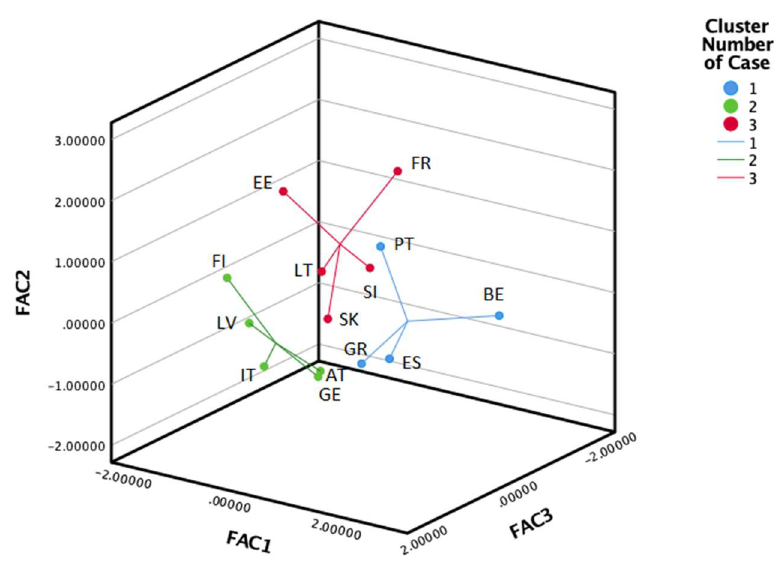
Figure 4. The “truncated” three-cluster case in 2010. Source Authors’ construction.